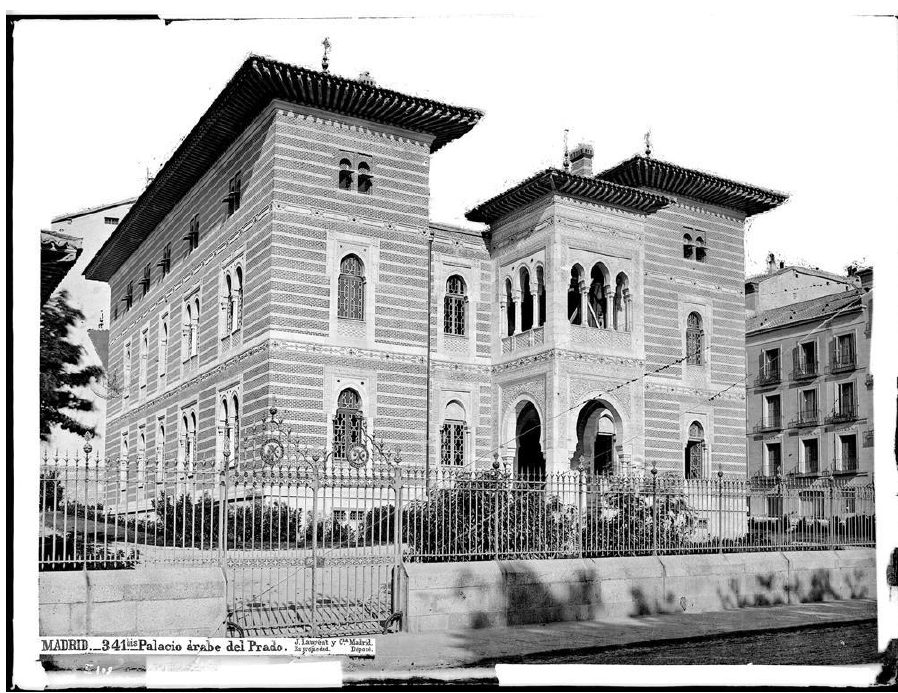
Figure 1. Façade of the Xifrè Palace, also known as the Arabian Palace of the Prado. Photo: Jean